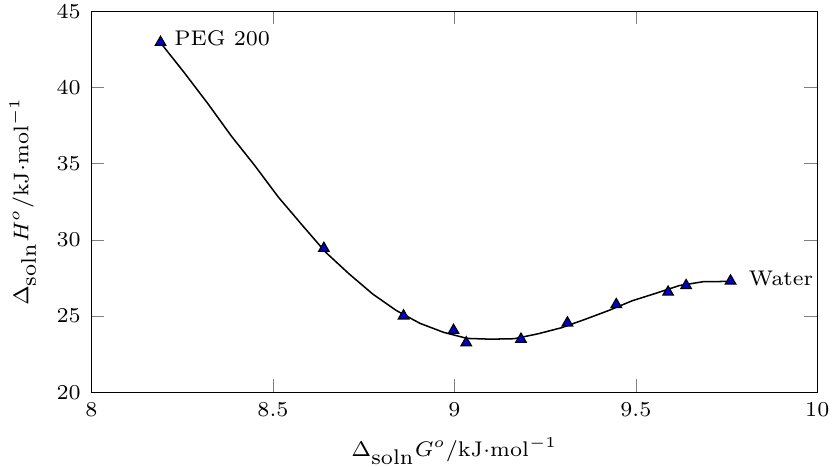
Figure 11. Enthalpy–entropy compensation plot for the solubility of isoniazid (3) in (PEG 200 (1) + water (2)) mixtures at T hm = 297.6 K.